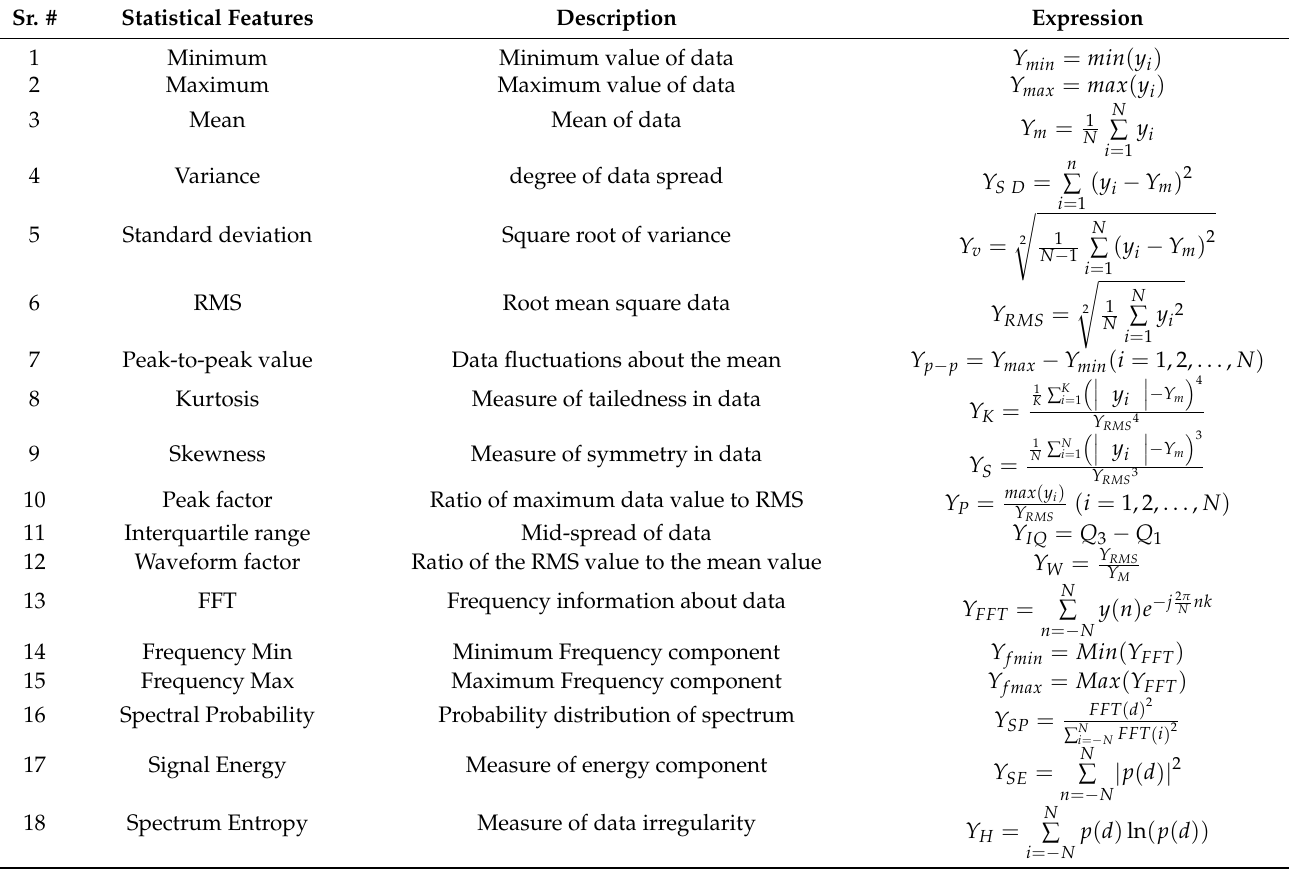
Table 3. Statistical feature expressions for correct